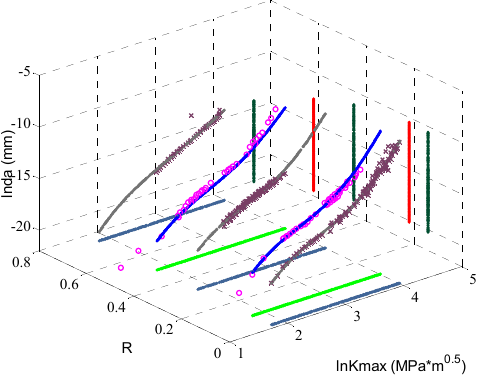
Figure 8. The fitting curves of ANN trained with part of data.